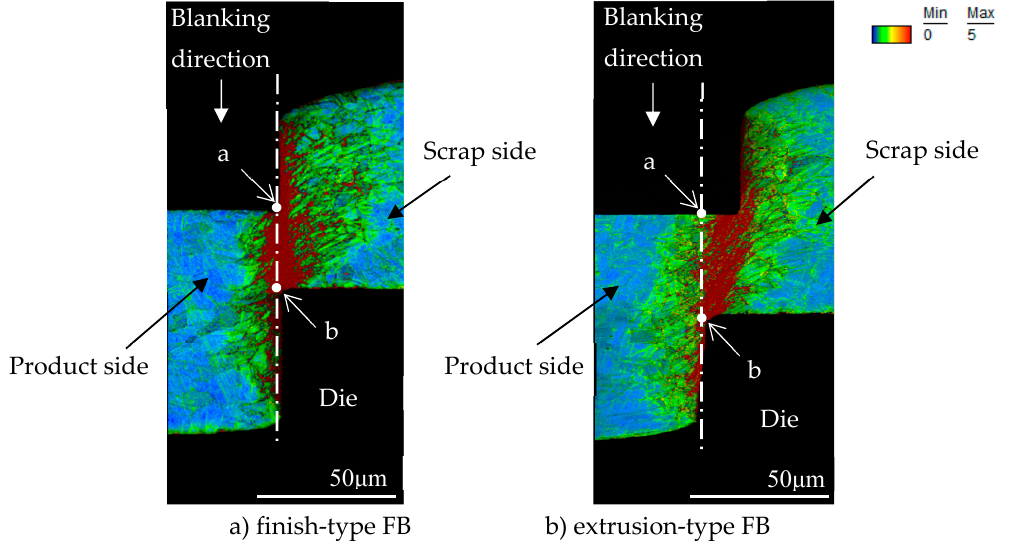
Figure 9. Comparison of kernel average misorientation (KAM) map for 60% t punch penetration between finish-type FB and extrusion-type FB: ( a ) finish-type FB; ( b ) extrusion-type